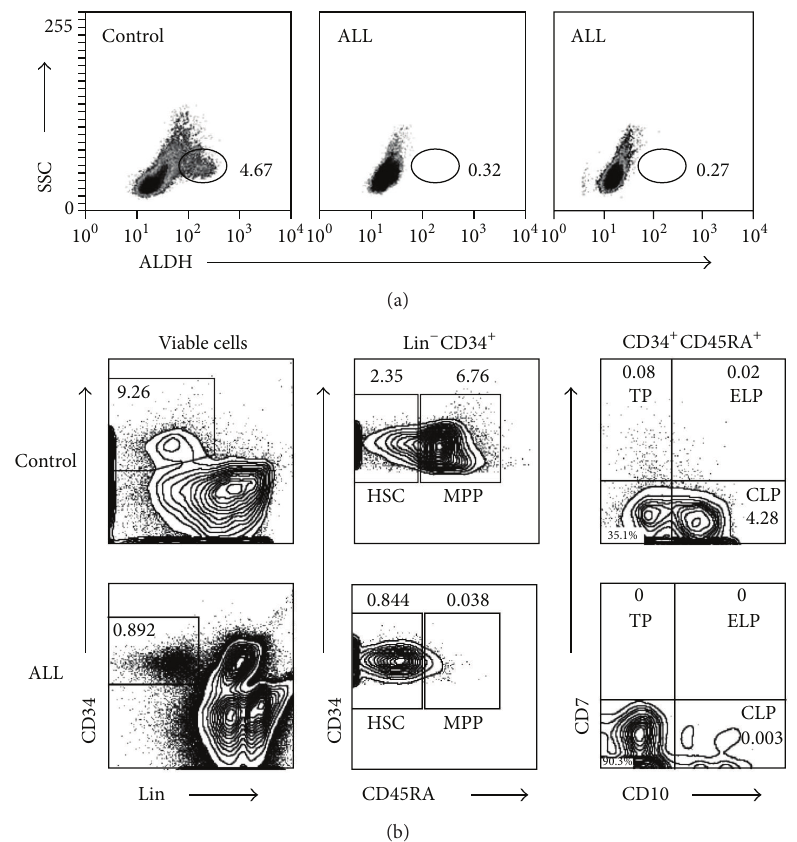
Figure 1: Hematopoietic and progenitor cell frequencies are critically reduced in acute lymphoblastic leukemia (ALL). The primitive cell fraction was identified in control and ALL bone marrow (BM) on the basis of its functional expression of aldehyde dehydrogenase. Two ALL samples and one control are shown (a). Mononuclear cells from ALL BM were resolved in stem and lymphoid progenitor populations according to CD34, CD45RA, CD7, and CD10 expression, and their frequencies were calculated and compared to normal counterparts (b). HSC were identified as Lin − CD34 + CD45RA − and MPP as Lin − CD34 + CD45RA + . MPP subfractionation gave rise to TP (Lin − CD34 + CD45RA + CD7 + CD10 − ), ELP (Lin − CD34 + CD45RA + CD7 + CD10 + ), and CLP (Lin − CD34 + CD45RA + CD7 − CD10 + ). HSC: hematopoietic stem cells; MPP: multipotent and multilymphoid progenitor cell fraction; TP: T-cell progenitors; ELP: early lymphoid progenitors; CLP: common lymphoid